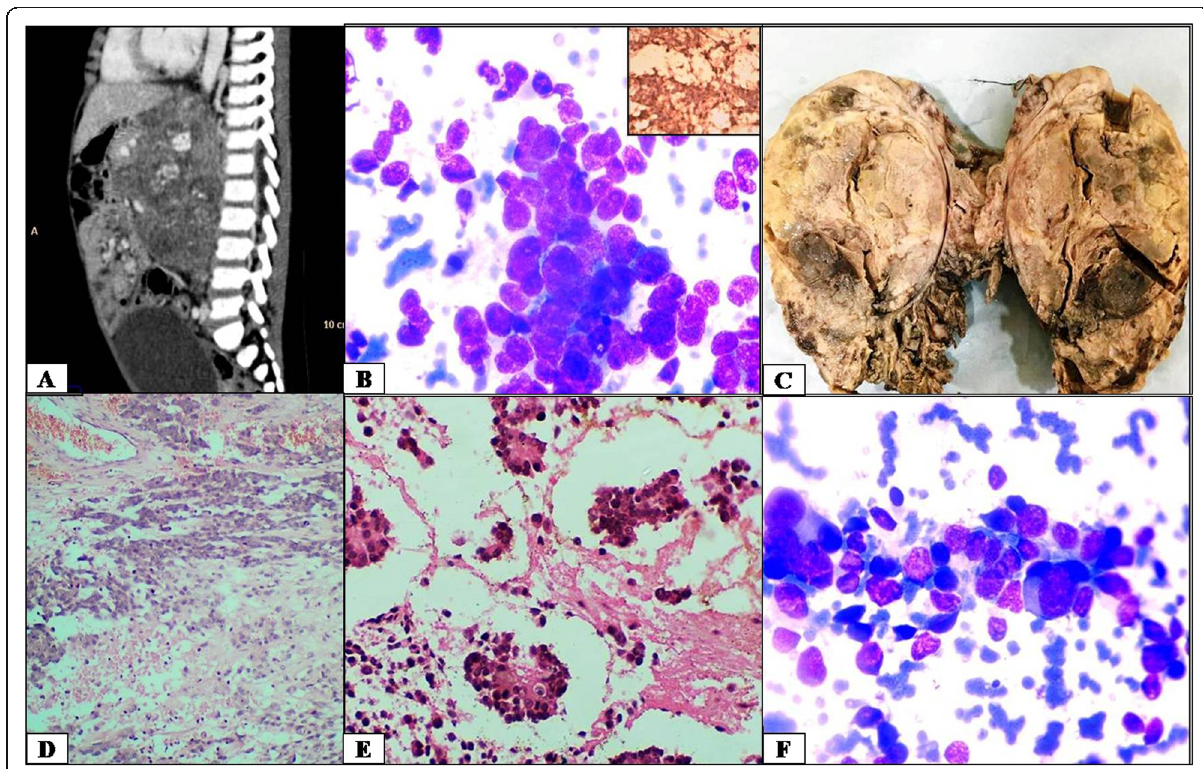
Fig. 1 A CECT abdomen shows a suprarenal heterogeneous mass with stippled calcification encasing major vessels. B Cellular fragments showing large atypical cells having moderate cytoplasm, pleomorphic nuclei and prominent nucleoli forming acini. (Giemsa, 400X). Inset: Melan A positive tumor cells (Immunocytochemistry, 400X, DAB as chromogen). C Adrenal mass showing solid, variegated lesion with large areas of necrosis and haemorrhage. D Microscopy shows a viable malignant tumor with geographical areas of necrosis, E Tumor cells forming rosettes (Hematoxylin & Eosin, 100X), F Reviewed cytology smears showing two population of cells (Giemsa,